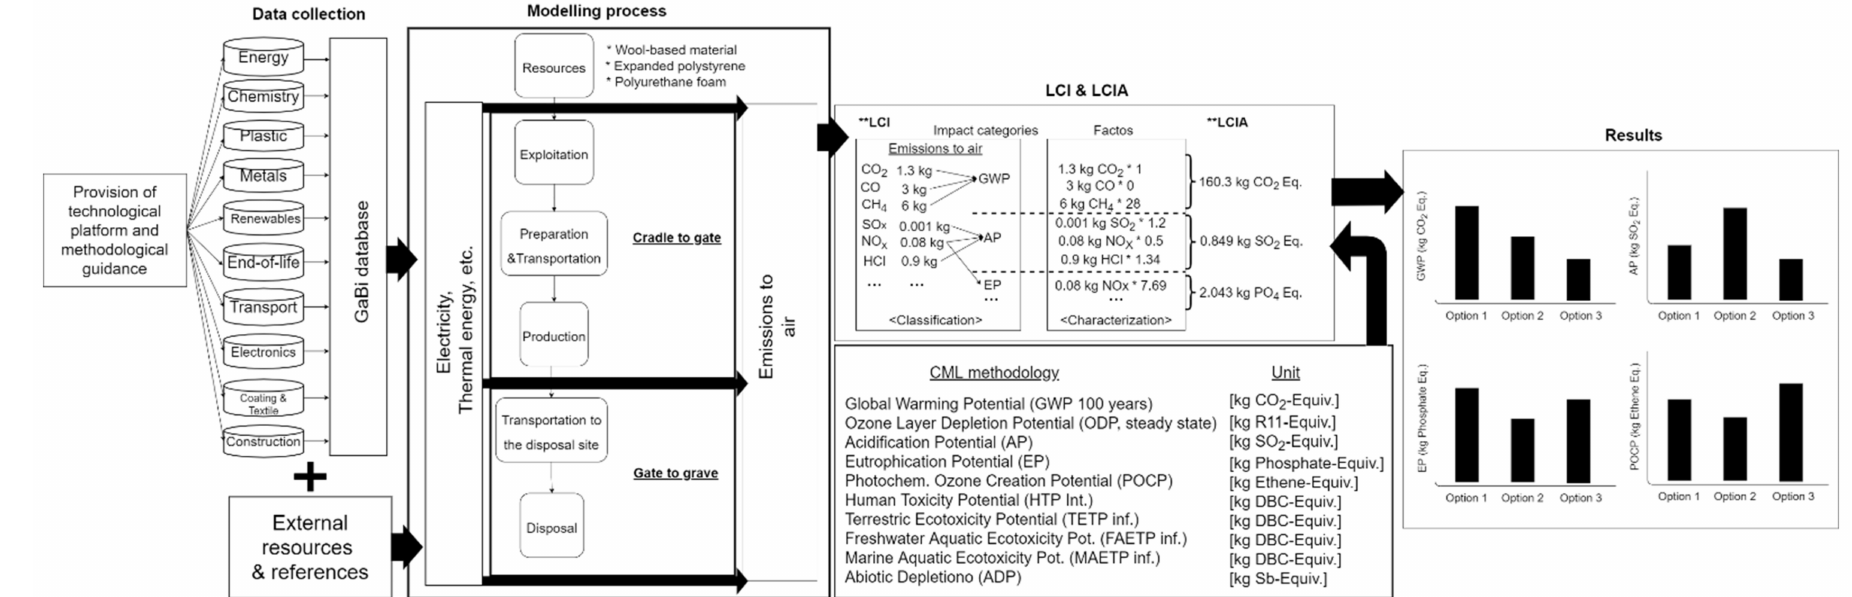
Figure 2. A schematic view of an outline of the LCA analysis